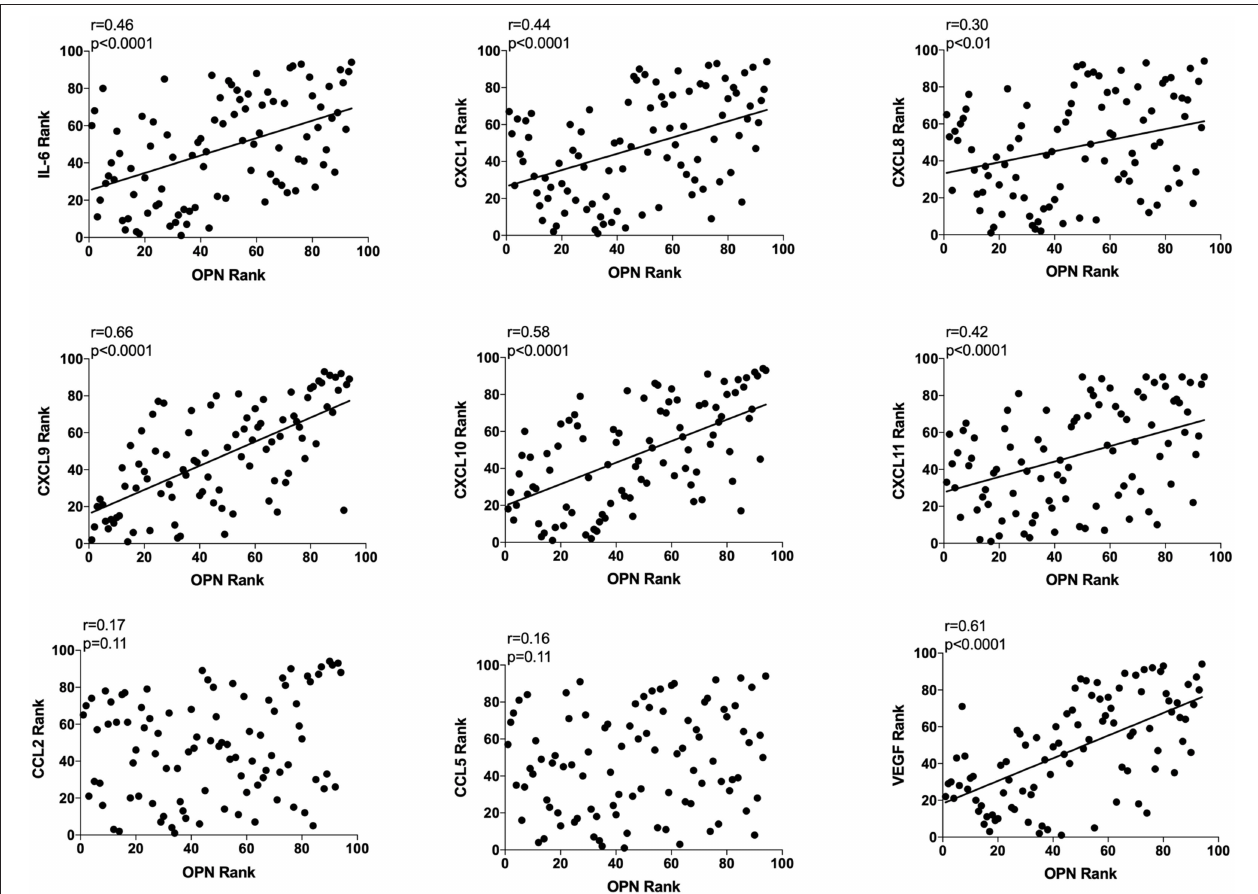
FIGURE 3 | Extracellular breast Osteopontin (OPN) levels in vivo and its correlations with extracellular inflammatory- and angiogenic proteins in vivo in normal human breast tissue. Microdialysis was used to sample in vivo extracellular molecules from breast tissue of women. Proteins were quantified using a multiplex proximity extension assay as described in the materials and methods section. A total of 94 microdialysis investigations of normal breast tissue unexposed to any treatment is depicted; 42 post-menopausal healthy volunteer women, attending the regular mammography-screening program; 21 post-menopausal women treated for early breast cancer investigated in their unaffected normal breast before the start of adjuvant tamoxifen therapy; 13 post-menopausal healthy volunteer women before the start of dietary flaxseed addition; 10 premenopausal healthy volunteer women before the start of dietary flaxseed addition and four premenopausal women in two consecutive luteal phases of the menstrual cycle. Statistics were calculated using Pearson’s correlations coefficient on ranked